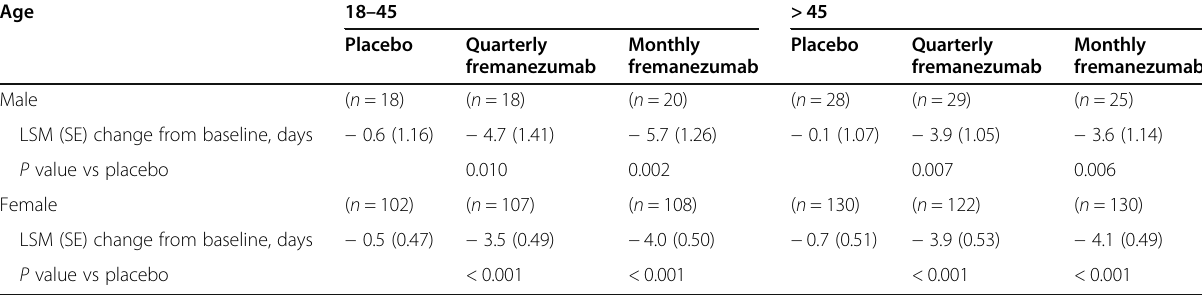
Table 2 Change in Monthly Migraine Days During 12 Weeks by Age and